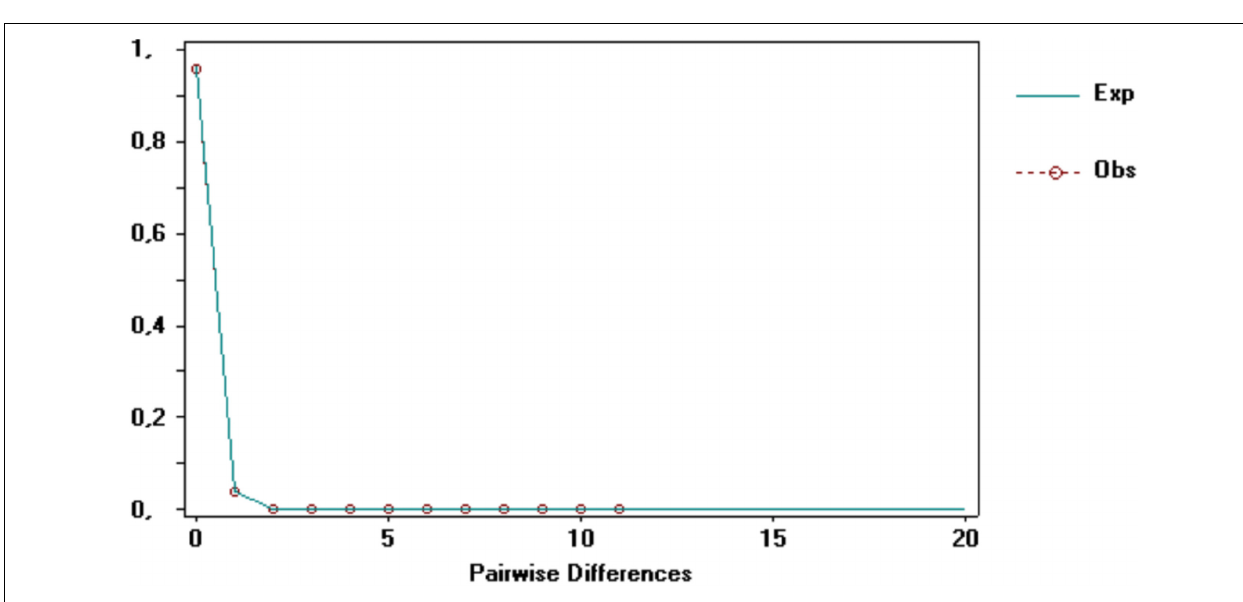
Frontiers in Marine Science |